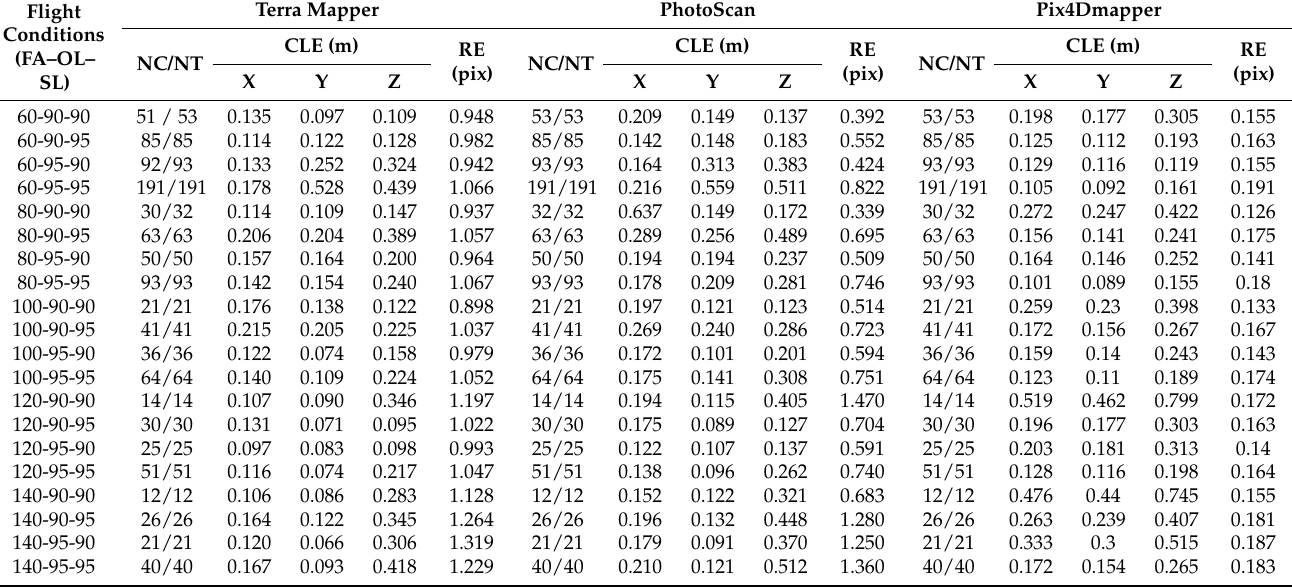
Table 3. Results of image matching, camera locations error, and reprojection error.